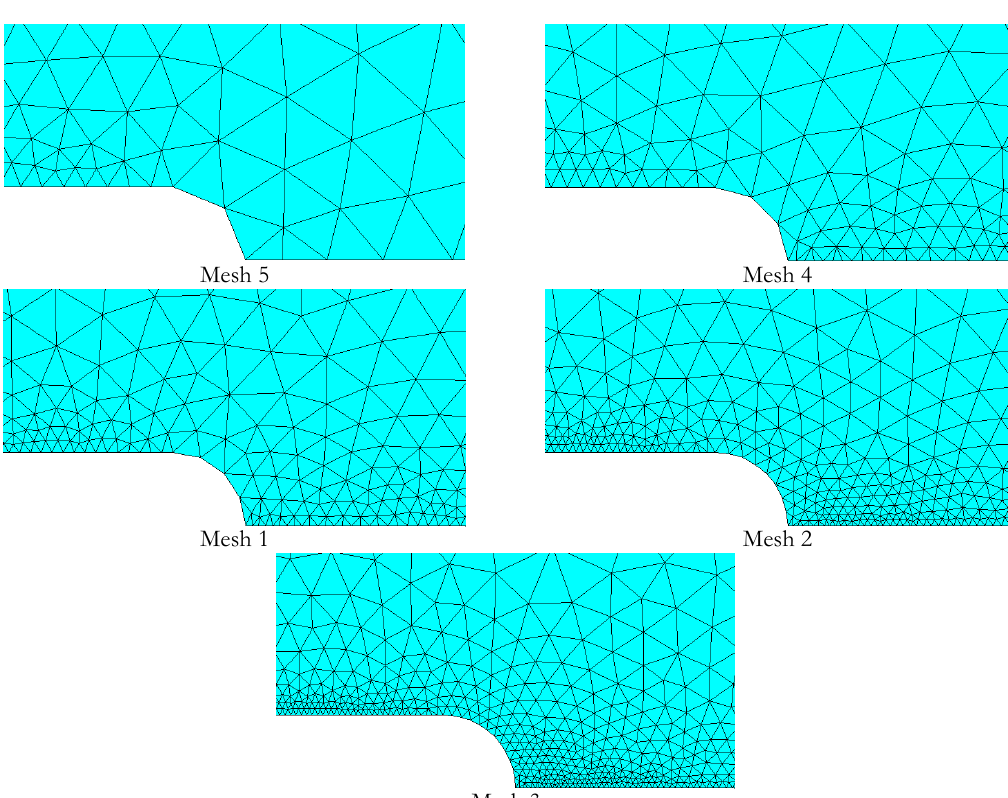
Figure 10: Finite element meshes used in the convergence study for the S355 steel ( ρ *